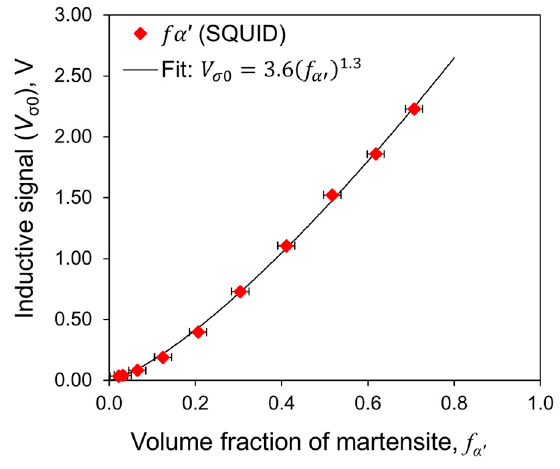
Figure 7. Relationship between the signal output (voltage) and the martensite content estimated using SQUID magnetization measurements.